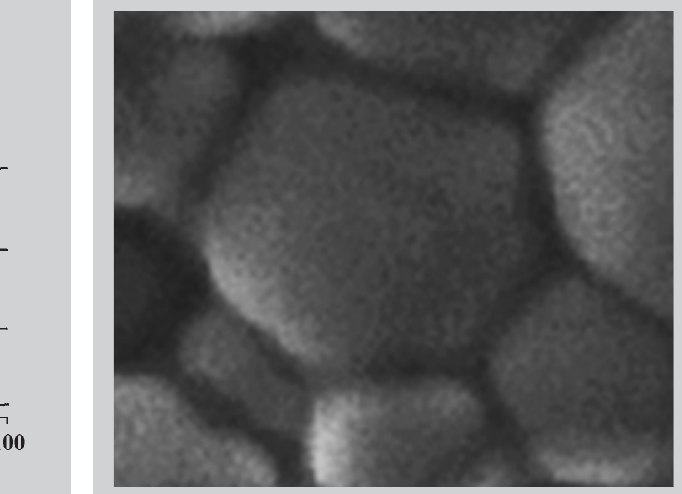
Figure 1 (left): Droplet size distributions of emulsions. Dotted line: according to the Gauss equation (Eq. 3). Figure 2: Shape of droplets in highly concentrated